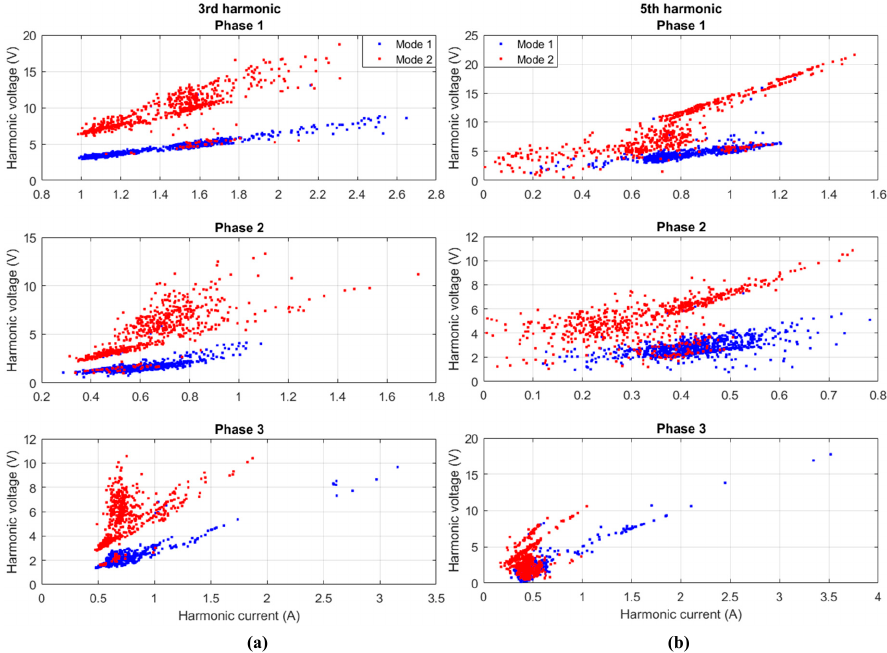
Figure 20. ( a ) The 1 h 3rd harmonic voltage and current values plotted against each other for Mode 1 and 2 seen in Figures 14–16. ( b ) The 1 h 5th harmonic voltage and current values plotted against each other for Mode 1 and 2 seen in Figures